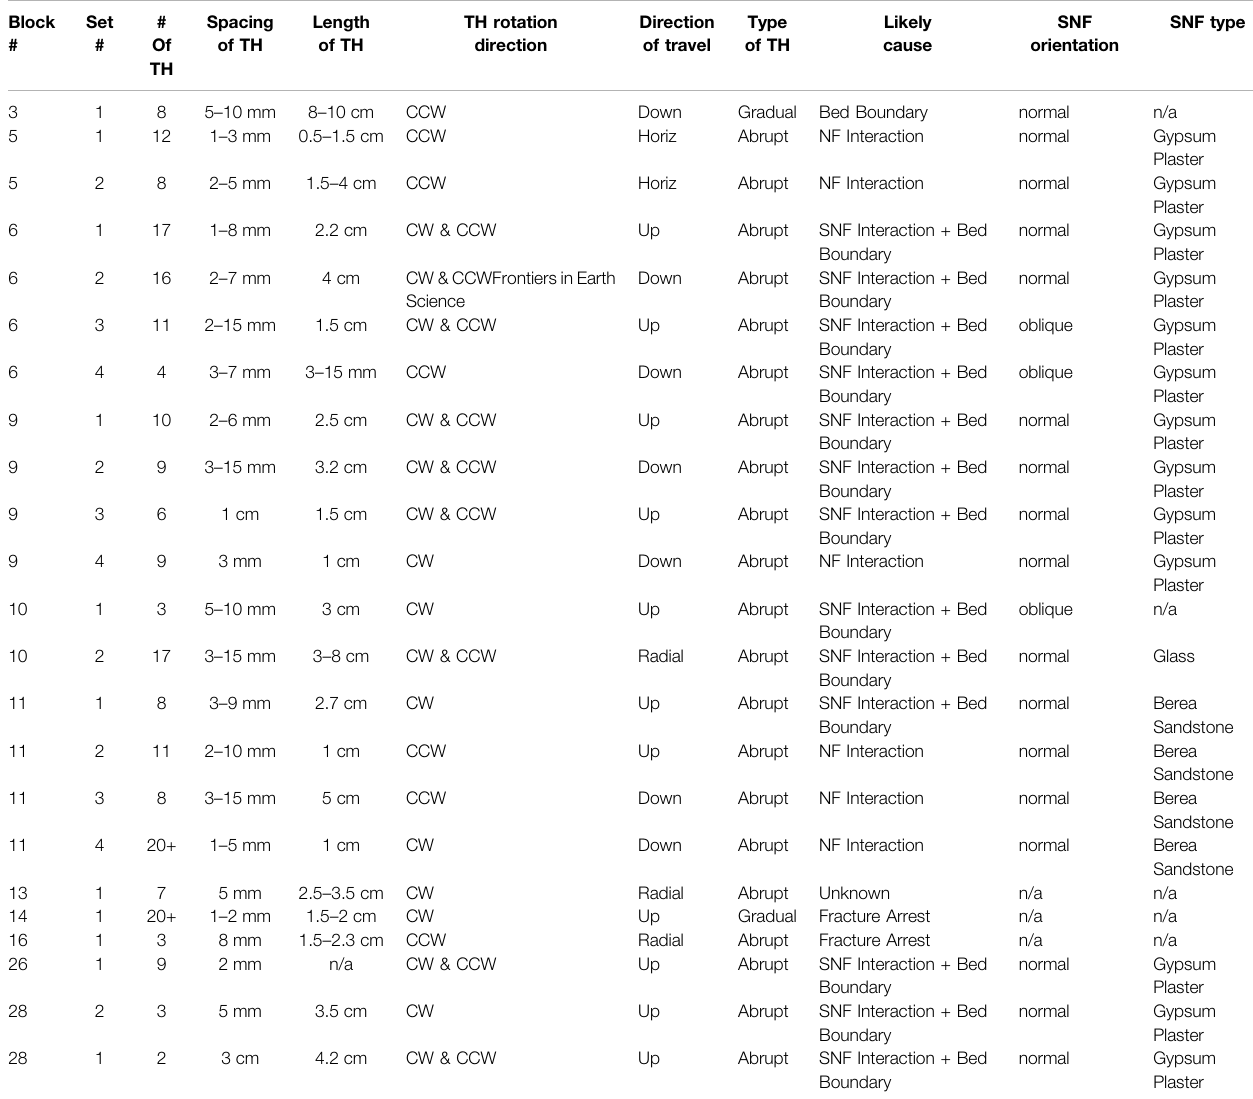
TABLE 2| All instances oftwist hacklesoccurringwithinthestudied experimental blockpopulation.Itshouldbenotedthatmultiplesets ofhacklescouldbeobservedwithin one single block. TH, Twist Hackles; SNF, Simulated Natural Fracture. “ SNF Orientation ” refers to the orientation of the simulated natural fracture relative to the propagating fracture, with “ normal ” indicating that the SNF was oriented 90 ° to that of the propagating hydraulic fracture, and “ oblique ” indicating that the SNF was oriented less than 90 ° to that of the propagating hydraulic fracture. The full dataset for all blocks can be found by referencing the Data Availability